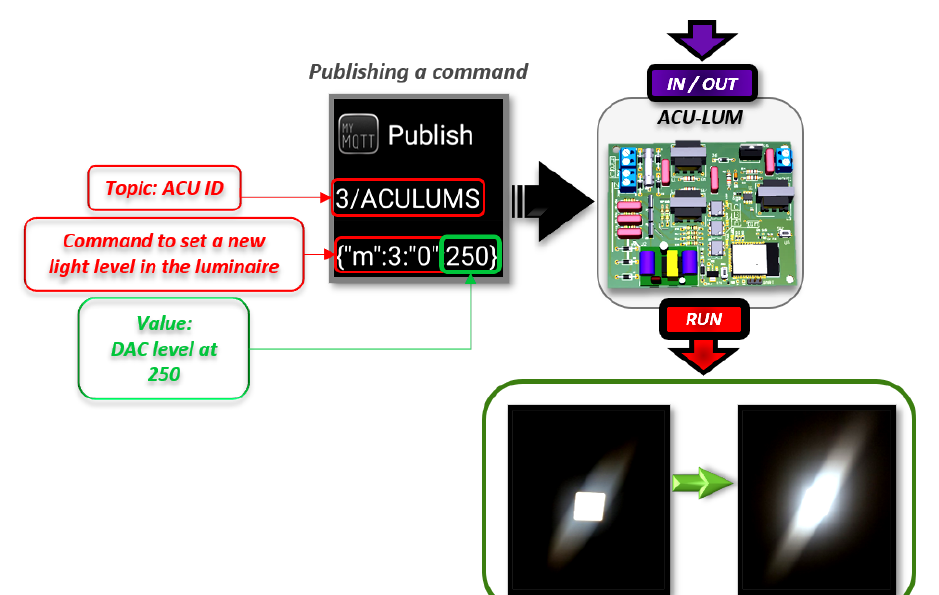
Figure 14. Light control DRF command execution.